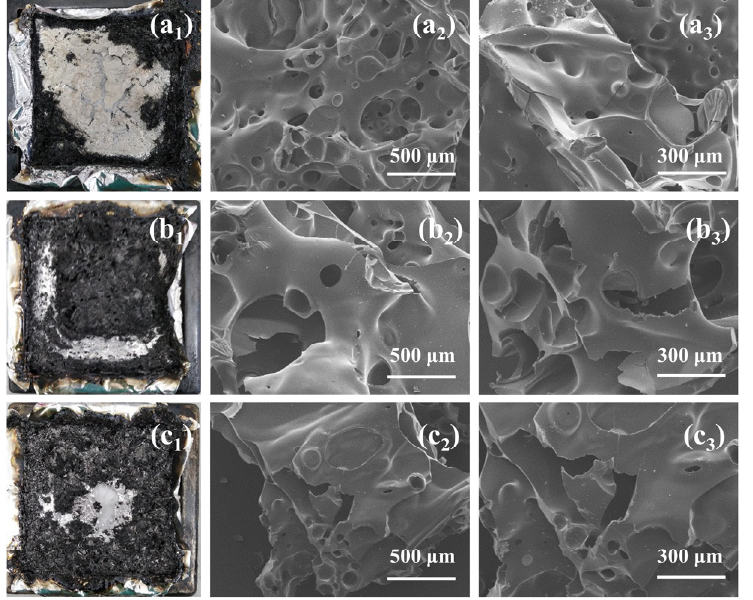
Figure 9. Digital photos and SEM images of the char residues of pure PET ( a 1~3 ), 2%hbDT/PET ( b 1~3 ), and 5%hbDT/PET ( c 1~3 ) after cone calorimeter tests. Subscript 1 is the digital photo, 2 is the SEM ( b 1 – b 3 ), and 5%hbDT/PET ( c 1 – c 3 ) after cone calorimeter tests. Subscript 1 is the digital photo, 2 is images (×60) and 3 is the magnified SEM images (×100). the SEM images ( × 60) and 3 is the magnified SEM images ( ×